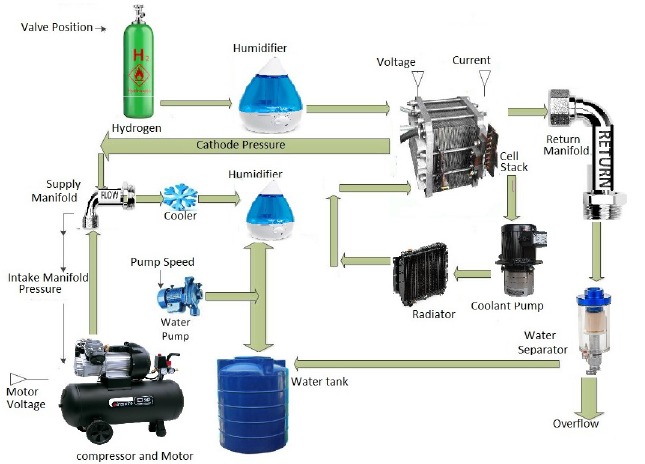
Fig 3. Fuel cell block